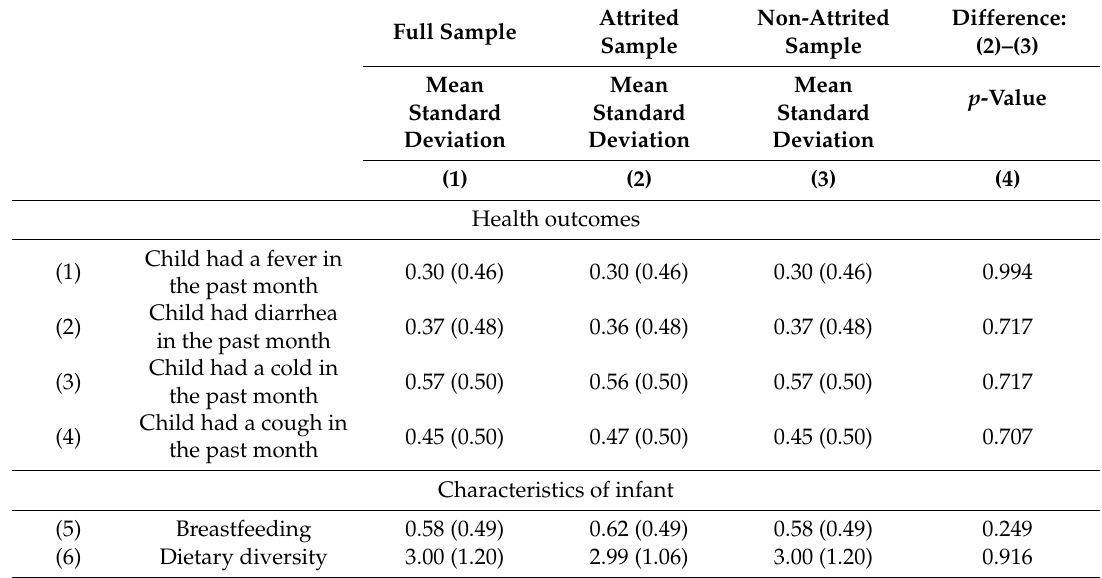
Table A2. Summary statistics of outcomes and covariates by attrition